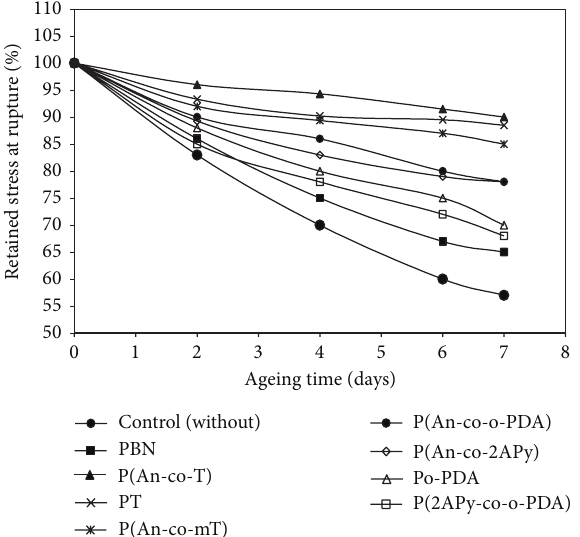
Figure 1: Retained strain at rupture versus ageing time for NR vul- canizates.